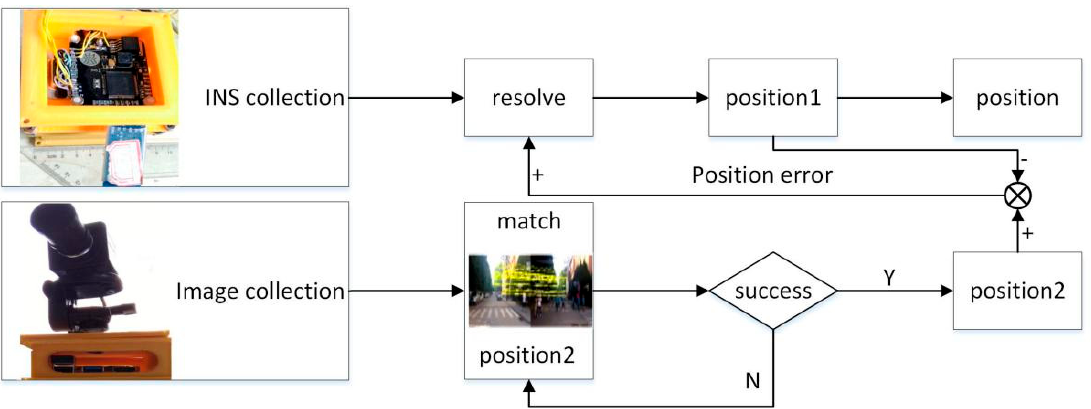
Figure 4. INS/vision brain-like navigation model.